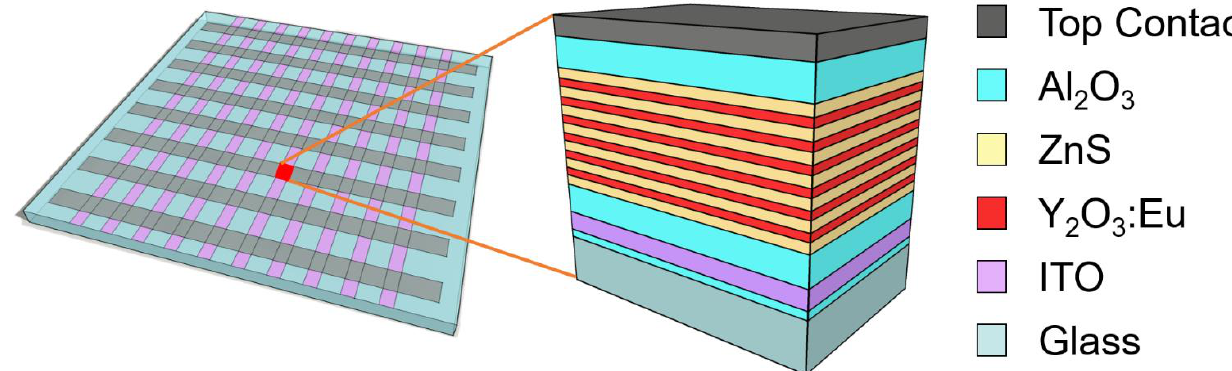
Figure 1. Schematic illustration of the passive matrix-like structure and the device cross section of the Y 2 O 3 :Eu/ZnS EL pixel prepared by ALD. The device is based on the multilayer electroluminescent structure proposed by T. Suyama et al. [19]. In this work, 6 layers of Y 2 O 3 :Eu and 7 layers of ZnS were used.